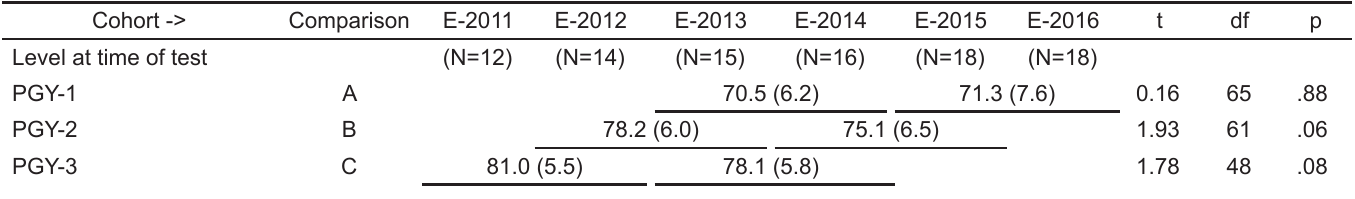
Table 1. Comparisons of ABEM in-training examination scores by cohorts of residents who participated in the flipped-classroom educational model and those who did not at different levels of